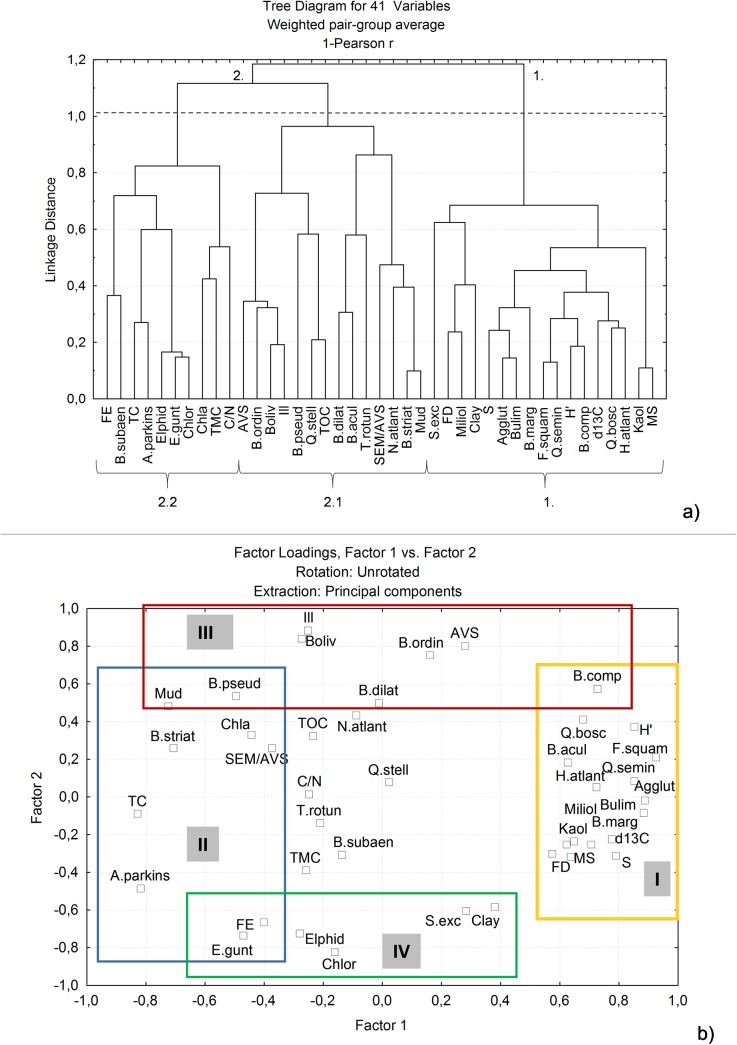
Principal components analysis based on the main benthic foraminifera species/taxa and: a) sedimentological data (grain size, mineralogical, geochemical and geophysical data); b) quantity and quality of organic matter and bacteria.Legend: Sand–sand fraction (>63μm); Mud–fine fraction (<63μm); clay–clay fraction (<2μm); total organic carbon–TOC; Chl–chlorite; Kaol–kaolinite; Berth–berthierine; Phyl–phyllosilicates; MS–magnetic susceptibility; AVS–acid volatile sulfides; SEM/AVS–simultaneous extracted metals and AVS ratio; FE—fecal enterococci; TC–total coliforms; TMC–total mesophilic counts; TBP—total of biopolymers; LIP–lipids; PTN–proteins; CHO–carbohydrates; Chla–Chlorophyll a; FD–foraminiferal density (n°/g); b) SI–Shannon Index; S–species richness; J–equitability.